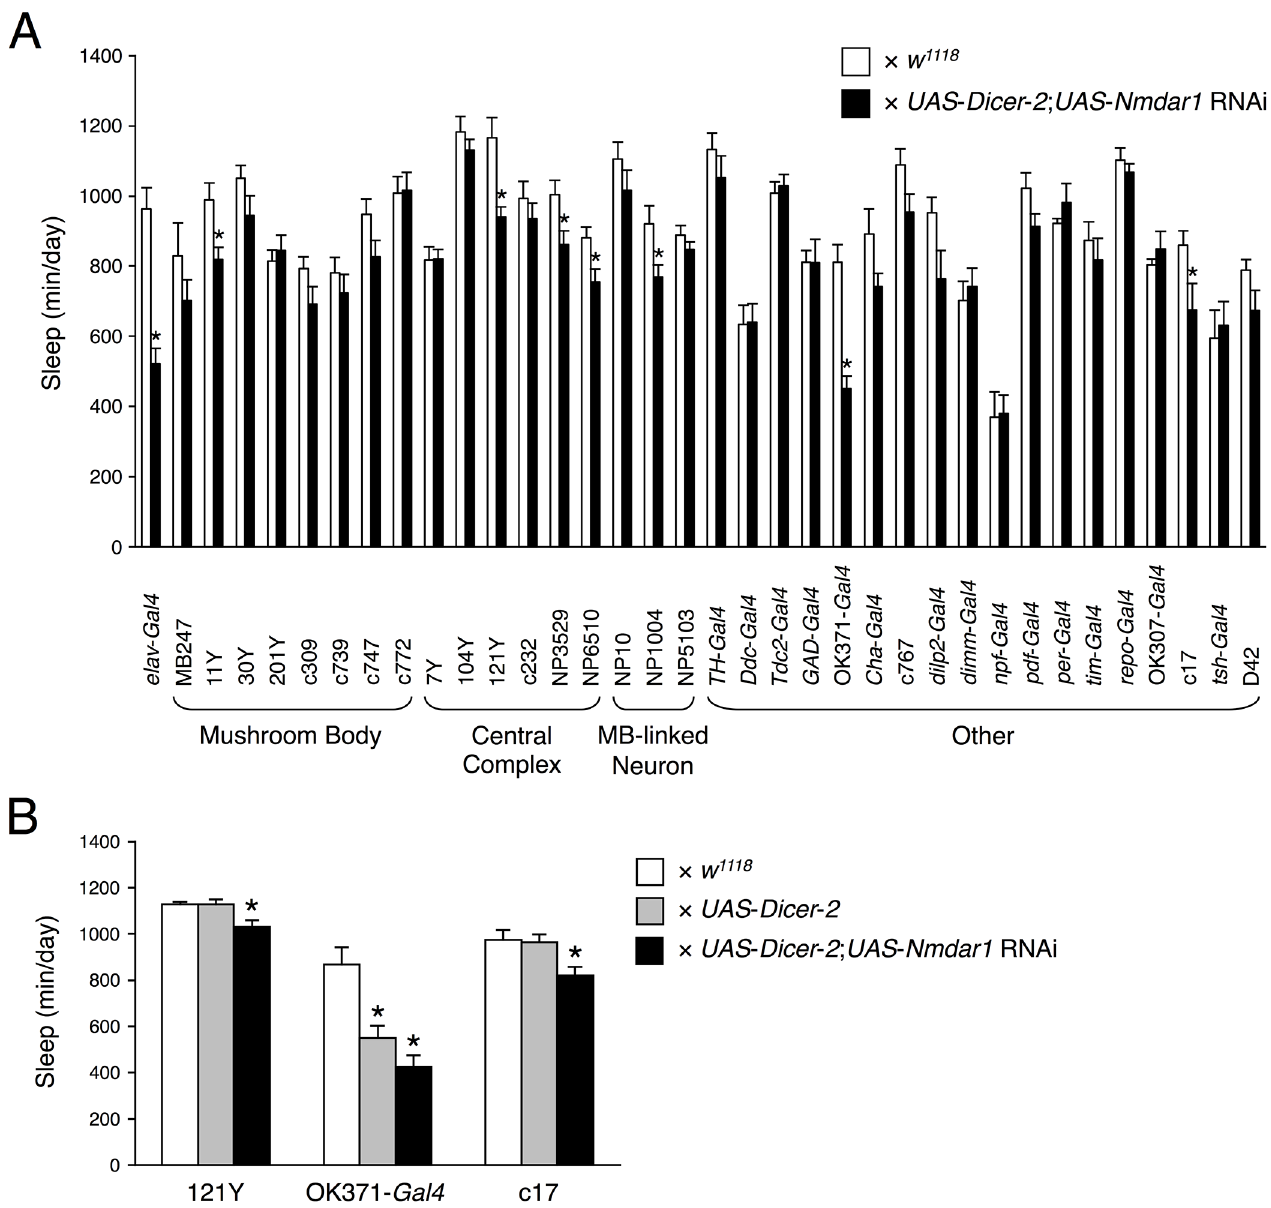
Fig 6. Nmdar1 knockdown in various regions of the fly brain. (A) Total sleep for progeny collected from between 36 Gal4 drivers and UAS - Nmdar1 RNAi (VDRC 37333) with the UAS - Dicer - 2 on the 2nd chromosome in DD conditions (black bars). For controls, each Gal4 driver was crossed to w 1118 flies (white bars). Data are presented as mean ± SEM ( n = 6 – 8 for each group). Asterisks indicate statistically significant differences from control determined by a t -test ( p < 0.05). (B) Total sleep for flies expressing Nmdar1 RNAi and Dicer - 2 transgenes under indicated Gal4 drivers (black bars) in DD conditions. For controls, each Gal4 driver was crossed to w 1118 (white bars) or UAS - Dicer - 2 flies (gray bars). Data are presented as mean ± SEM ( n = 7 – 16 for each group). Groups with asterisks indicate statistically significant differences (Tukey-Kramer HSD test for normally distributed data, p <